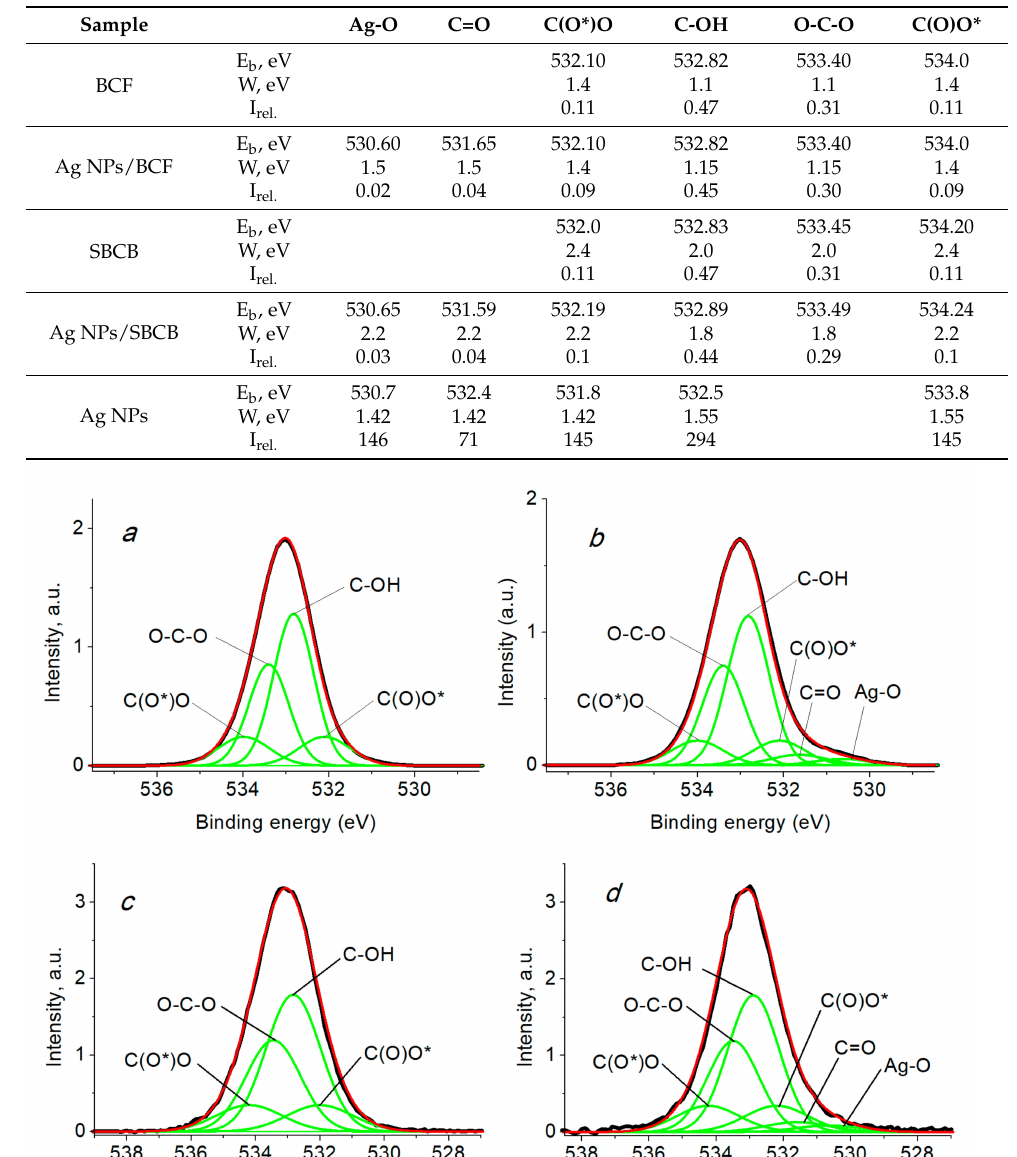
Table 4. Characteristics of the O 1s photoelectron spectra: binding energies (E b ), Gaussian widths (W), and relative intensities (I rel ) of photoelectron peaks belonging to different chemical groups.